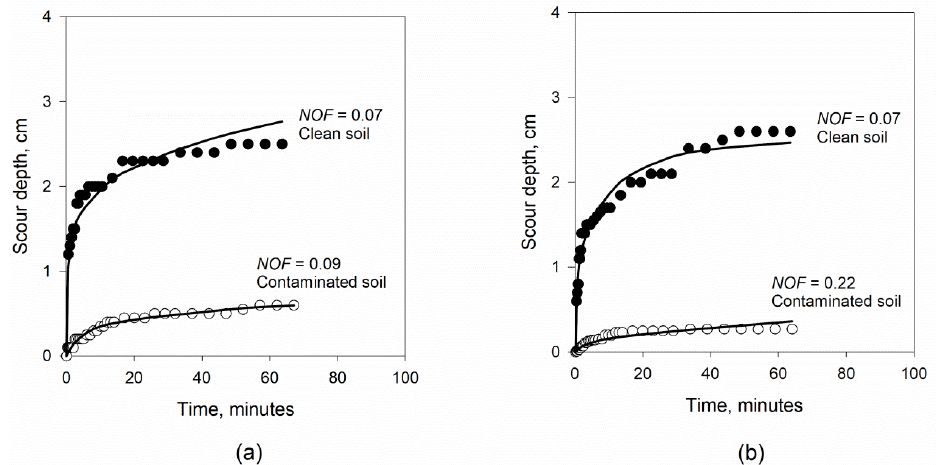
Figure 4. Wilson model evaluation using observed date for clean and oil contaminated soils at dry side for ( a ) small scale and ( b ) large scale. Note that empty circles represent the observed scour depth of contaminated soil by crude oil, solid circles represent the observed scour depth of clean soil, and solid lines represent predicted scour depth using the Wilson model.